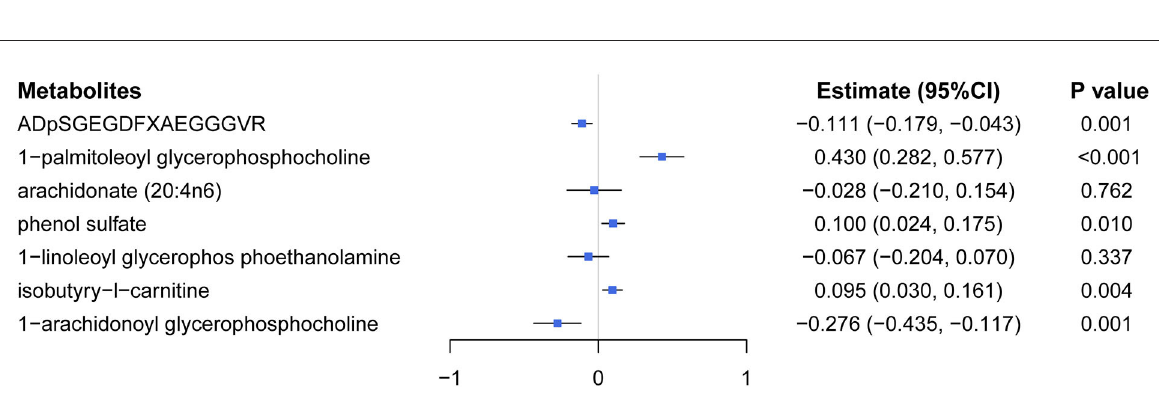
Consistent with our result, a high concentration of N- acetylornithine (NAC) is associated with an increased risk of high bone turnover, which is a major determinant of osteoporosis in late post-menopausal women (40). On one hand, supplementation with NAC can treat OVX-induced osteoporosis in a mouse model of bilateral ovariectomy by simultaneously reducing osteoclast bone resorption, reactive oxygen species (ROS), and DNA damage (41).